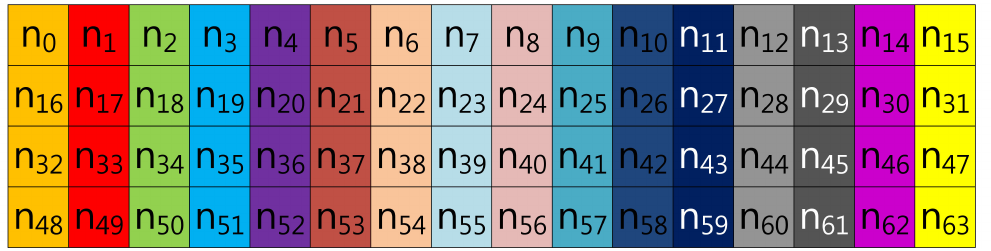
Figure 2. Look-up table structure of Tsaur and Chou’s method in a block form for 2NAF.